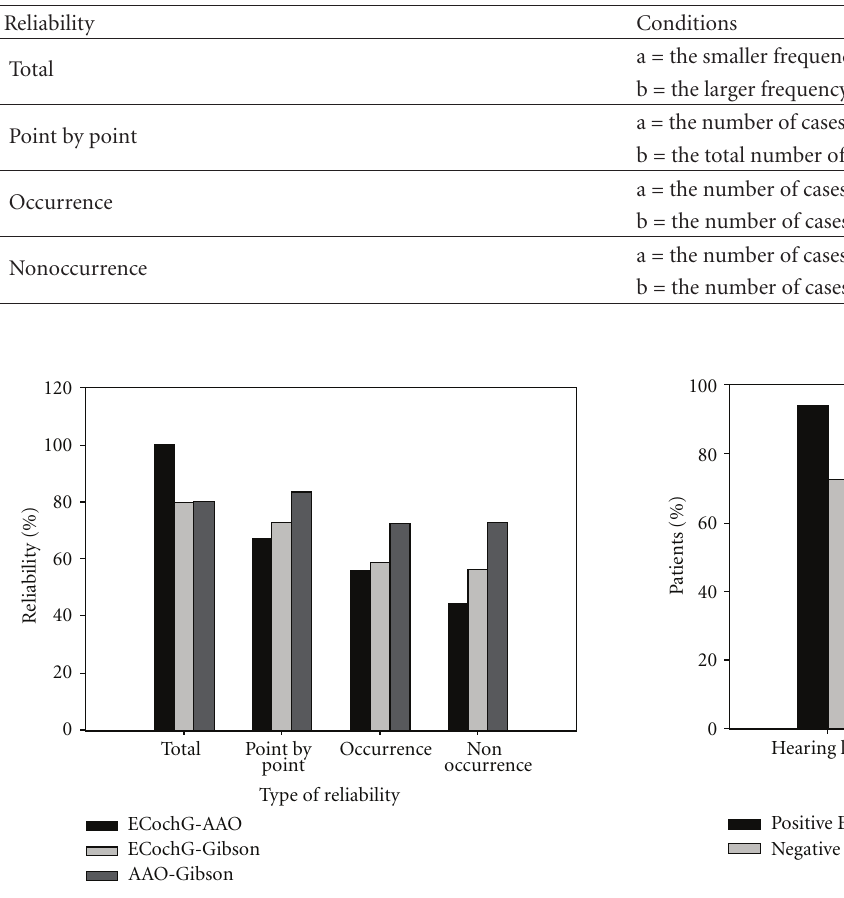
Figure 6: Percentage of patients showing each of the four key symptoms of